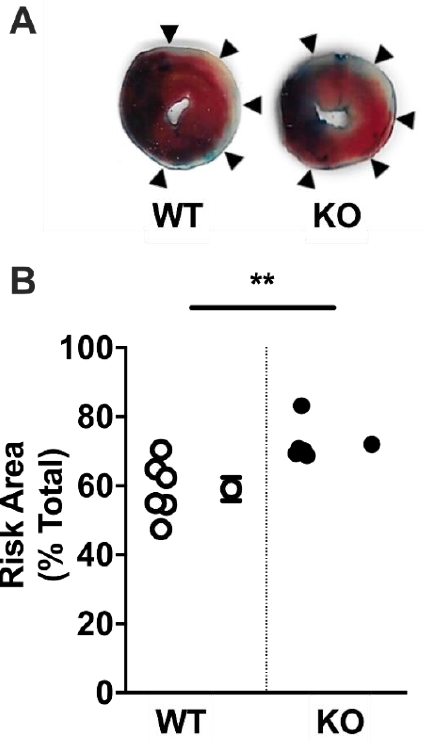
Figure 4. LINC00961 knockdown increases area at risk of myocardial infarction. ( A ) Myocardial infarction risk area (pink and white, indicated by arrows) relative to total heart area (blue, pink, and white) in heart tissue collected 30 min after left anterior descending coronary artery ligation in 9-week-old male mice. ( B ) Individual (left) and mean areas at risk in WT (white) and KO (black) mice (both n = 6). Student’s t-test. Data are mean ± SEM. ** p < 0.01.